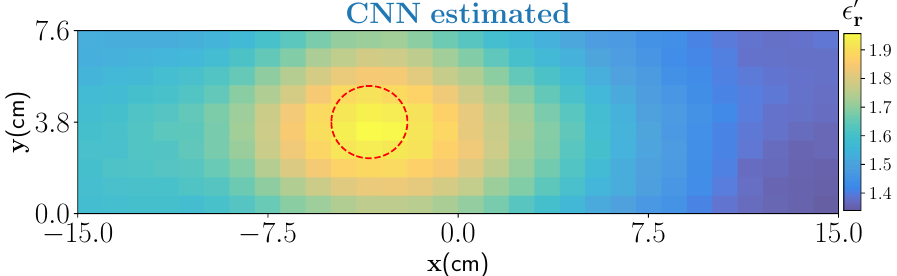
Figure 9. CNN estimation of cylindrical Teflon resin placed inside the foam. The true location of the target is marked by red-dash